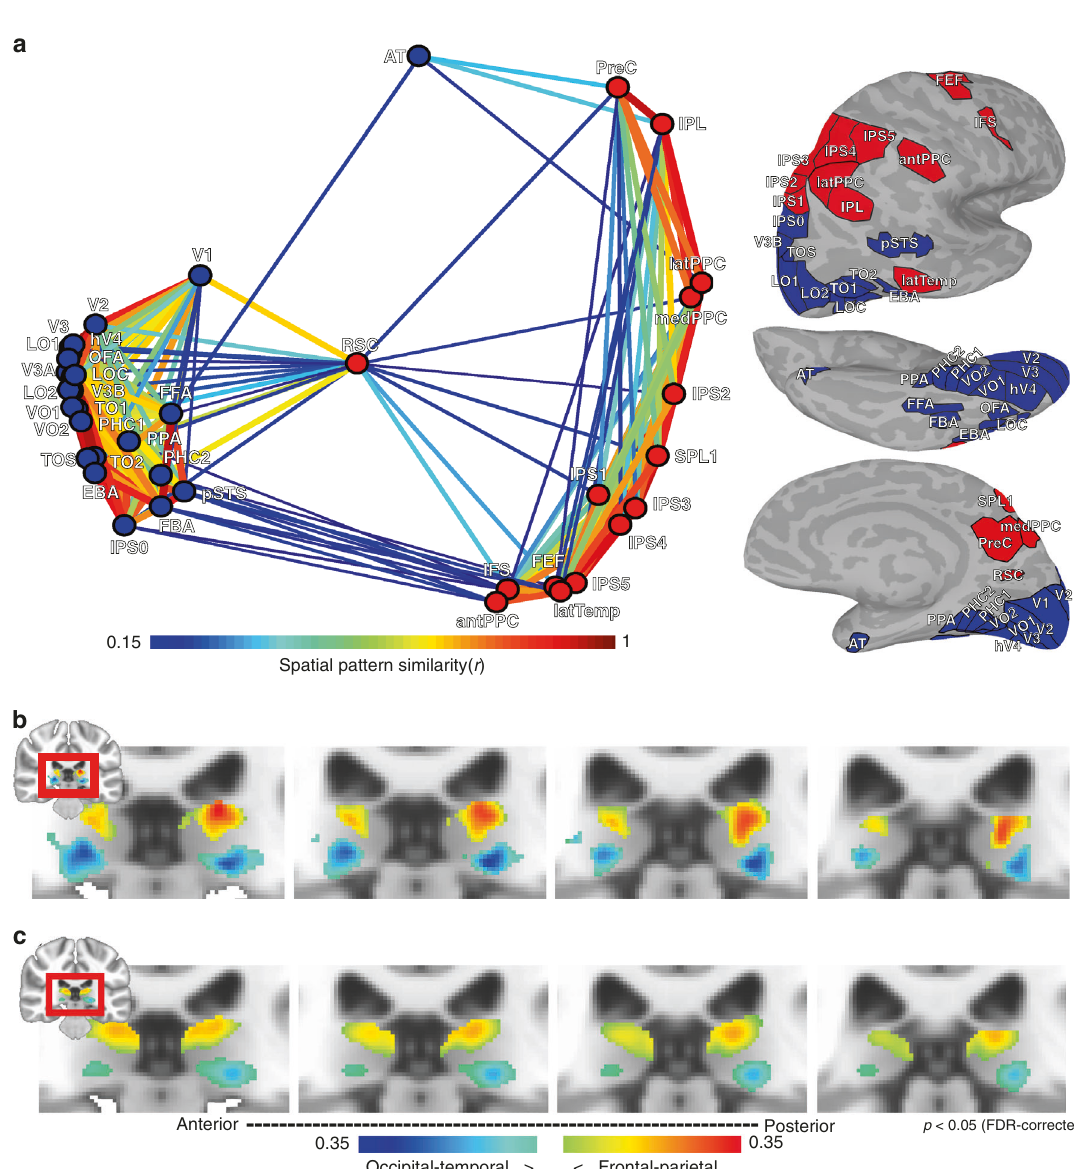
Fig. 2 Organization of pulvino-cortical functional coupling. a 2D plot of multidimensional scaling on the group average ( n = 13) pattern similarity of pulvino- cortical functional coupling between 39 cortical areas. Only ipsilateral correlations were considered. Data clustering yielded 2 groups. One cluster (blue) mainly contained occipital and temporal cortical areas associated with the ventral visual stream. The other cluster (red) mainly contained frontal and parietal cortical areas associated with the dorsal visual stream. Line thickness and color coding re fl ects similarity strength between areas. Surface fi gures illustrate all cortical areas tested; fi ll color matched to assigned cluster. b The difference between the two cluster ’ s pulvino-cortical connectivity maps segmented the pulvinar into dorsal and ventral sections. Colors correspond to the blue and red clusters shown in ( a ), threshold at an p < 0.05 FDR- corrected. c Same analysis as in ( b ), but from calculating pulvino-cortical connectivity maps using the Human Connectome Project ’ s 180 cortical areas